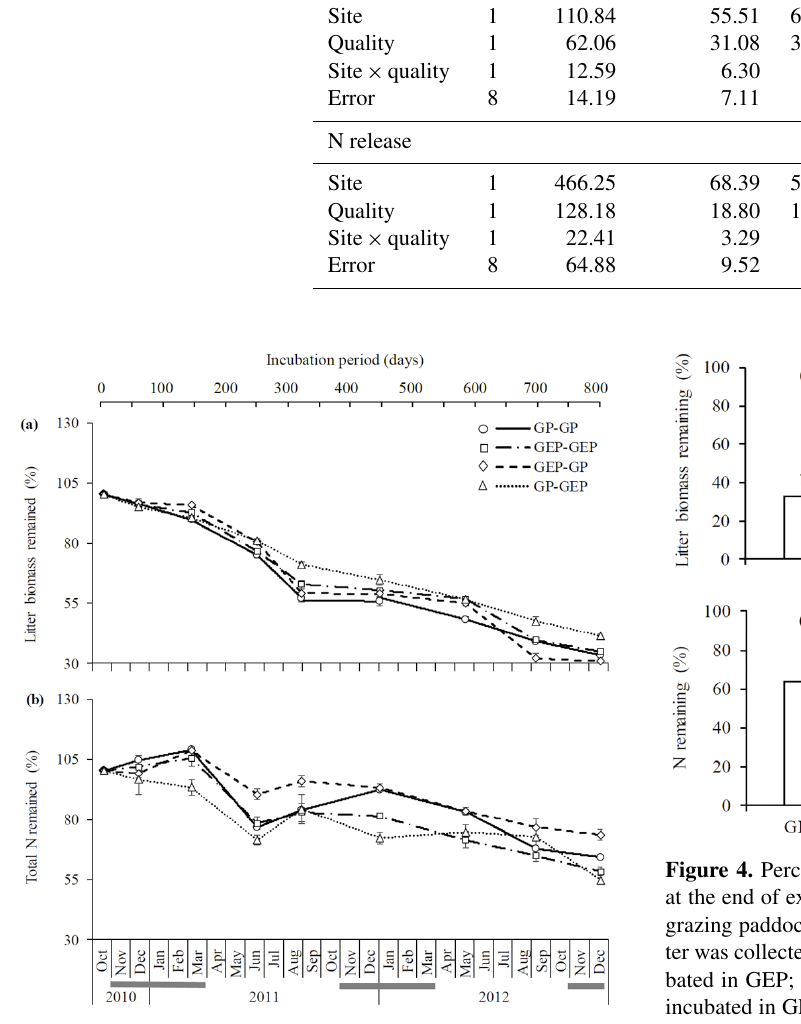
Figure 3. Dynamics (mean ± SE) of litter decomposition (a) and N lease (b) on the QTP. GP-GP: mixed litter was collected from graz- ing paddocks (GP) and incubated in GP; GEP-GEP: mixed litter was collected from grazing exclusion paddocks (GEP) and incu- bated in GEP; GEP-GP: mixed litter was collected from GEP and incubated in GP; GP-GEP: mixed litter was collected from GP and incubated in GEP. Grey lines under months indicate the mean air temperatures < 0 ◦ C.